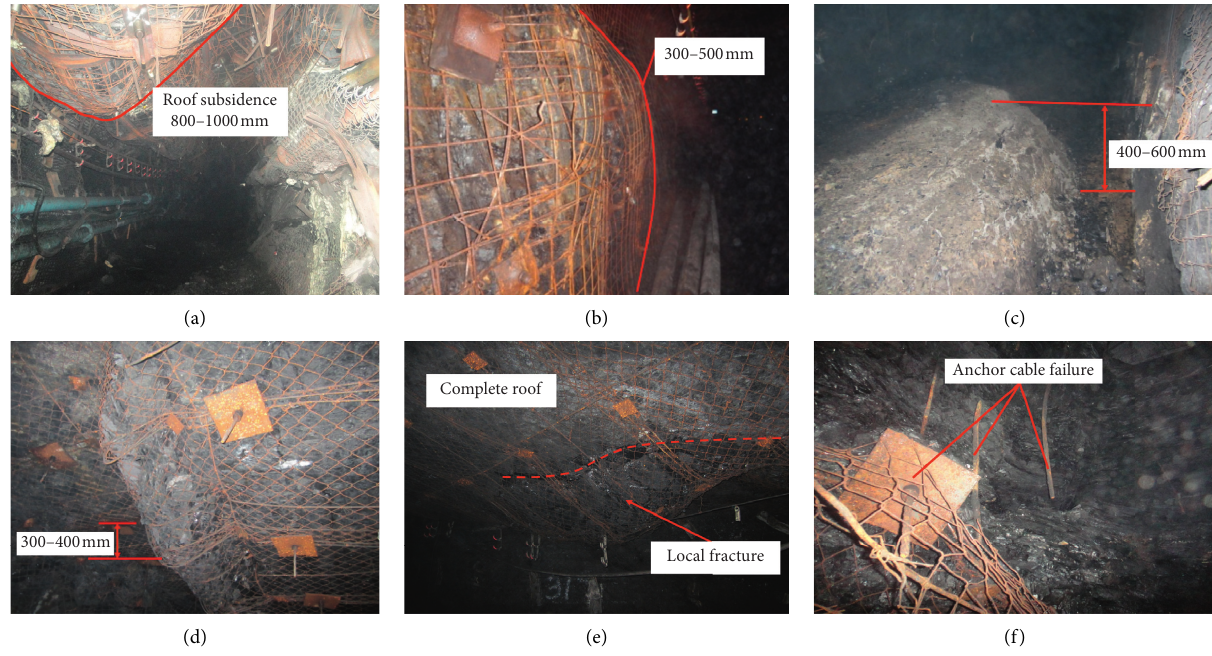
Figure 1: Deformation and failure characteristics of surrounding rock in the mining-influenced roadway.